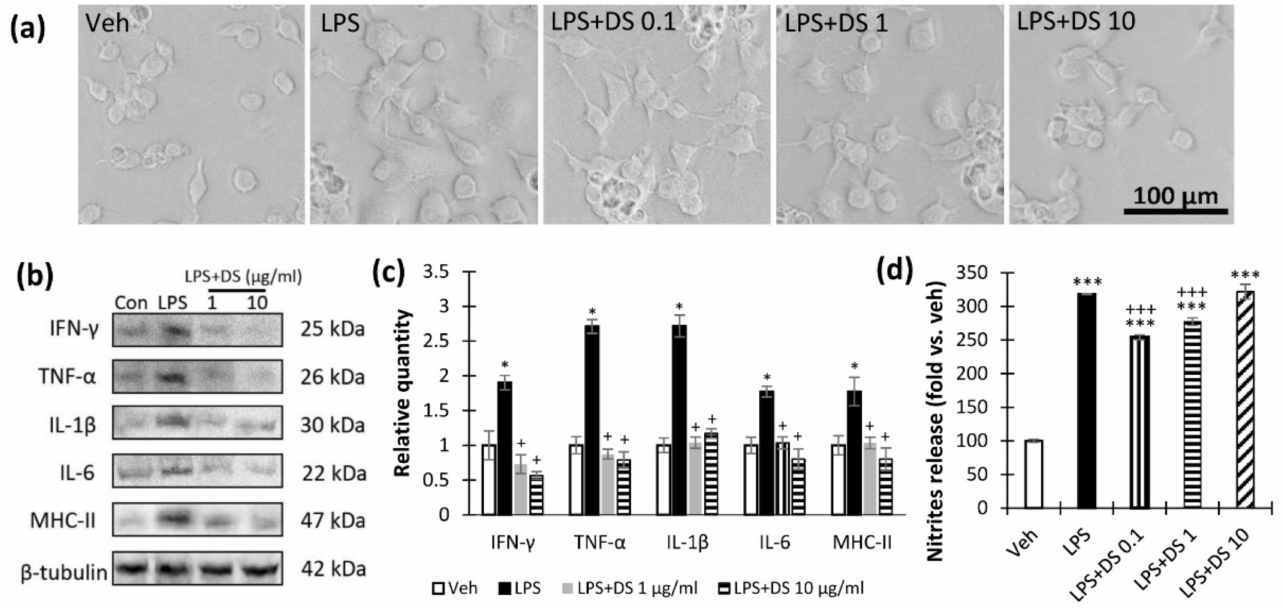
Figure 3. Effects of LPS and DS treatment on microglial morphology, proinflammatory cytokines,